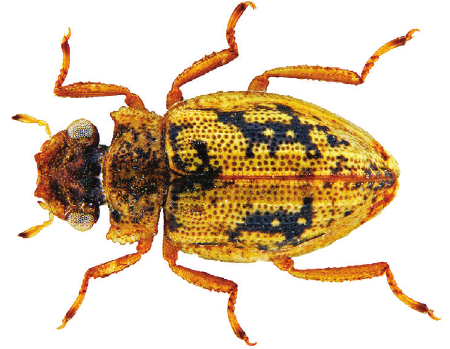
Figure 8. Spercheus cerisyi Guérin-Méneville, 1842 2.4 mm, iSimangaliso Wetland Park, Eastern Shores (site 14), February 2015 DT Bilton, MS Bird & R Perissinotto leg.